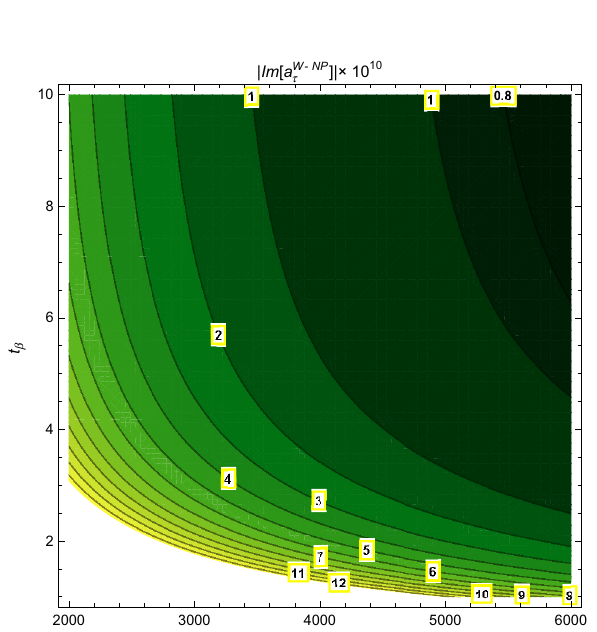
Fig. 10 The same as in Fig. 8 but for the imaginary part of a W − NP τ